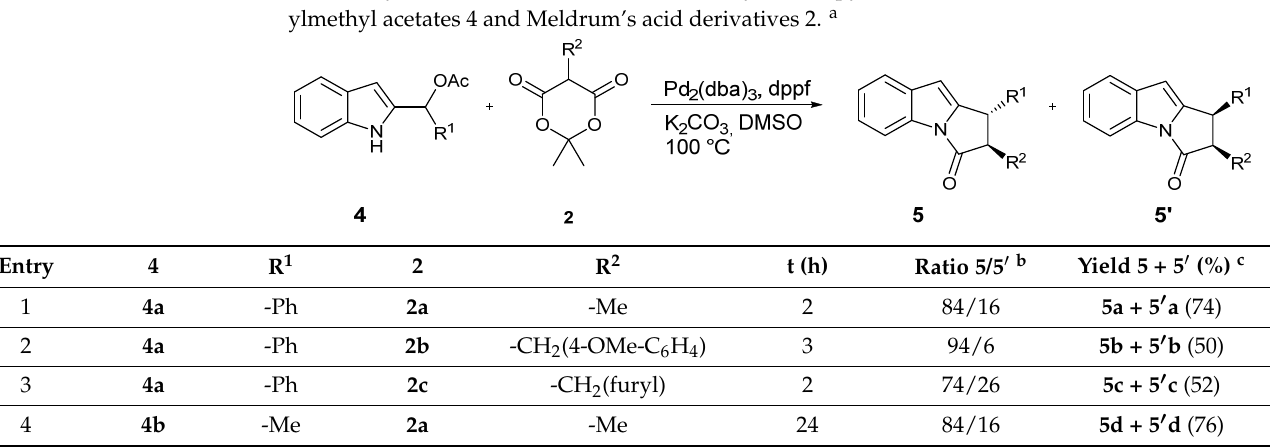
Table 3. Synthesis of 1,2-disubstituted 1,2-dihydro-3 H -pyrrolo[1,2- a ]indol-3-one 5/5 ′ from indol-2- ylmethyl acetates 4 and Meldrum’s acid derivatives 2.